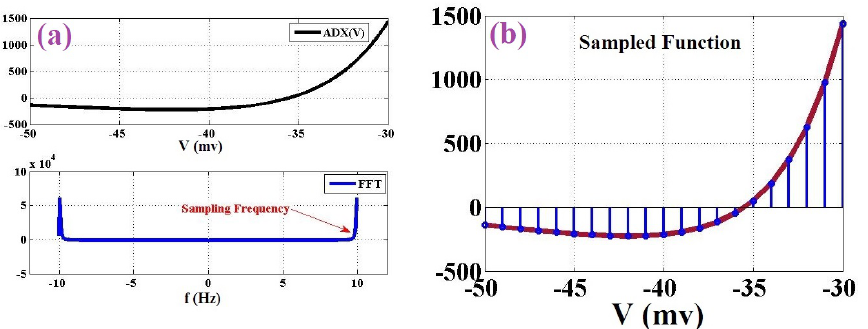
Figure 2. ( a ) FFT of the objective function based on the variation of voltage variable. ( b ) Sampled function based on the Nyquist rate (20